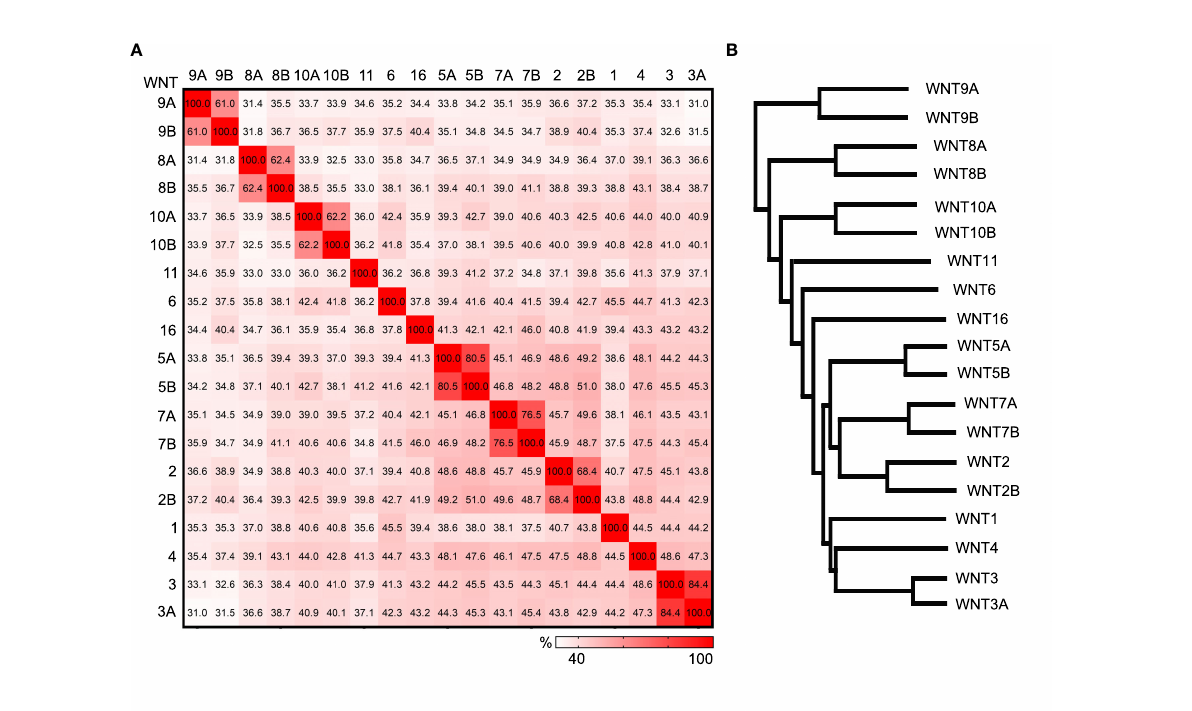
FIGURE 2 Comparison of human WNT ligands. (A) Heat plot showing the percent identity matrix of the 19 human WNT amino acid sequences. (B) Phylogram showing the relatedness of the 19 human WNTs. Sequence compared using the Clustal Omega multiple sequence alignment